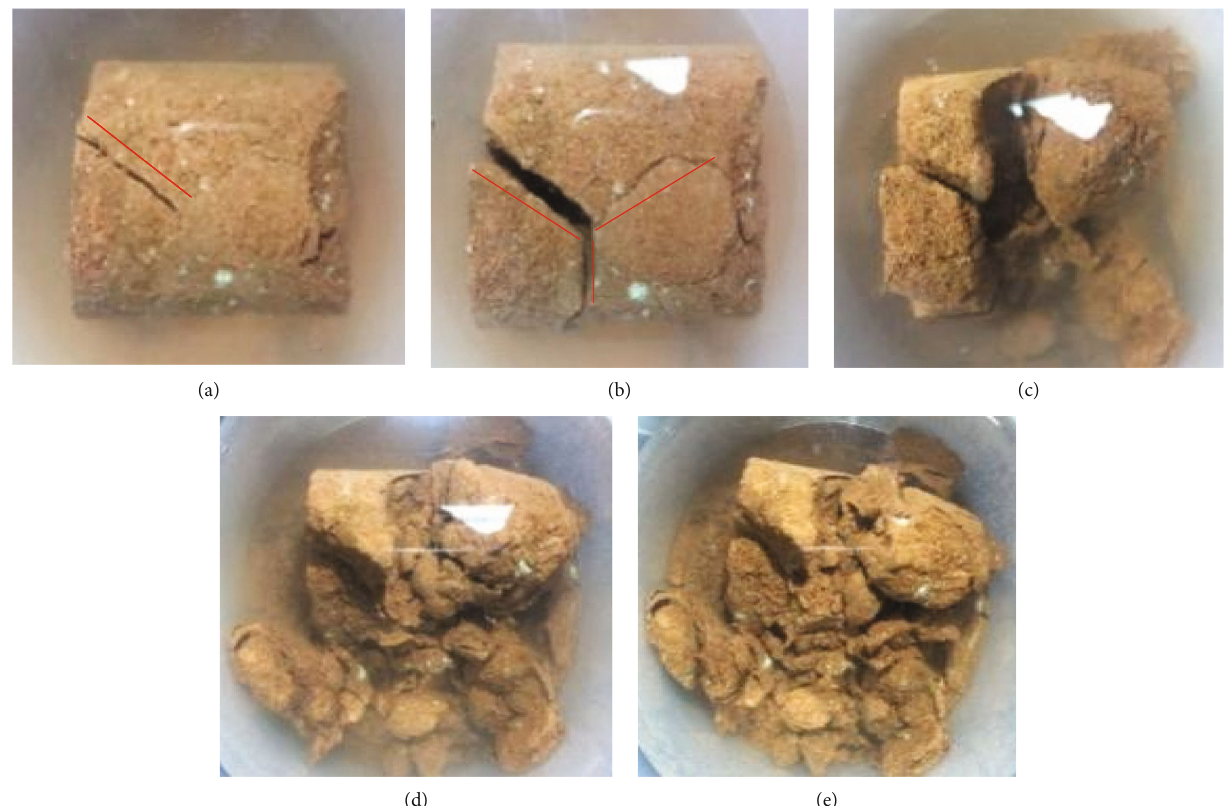
Figure 9: Disintegration of the mudstone ((a) after 1 minute in water, (b) after 10 minutes, (c) after 20 minutes, (d) after 60 minutes, and (e) after 26